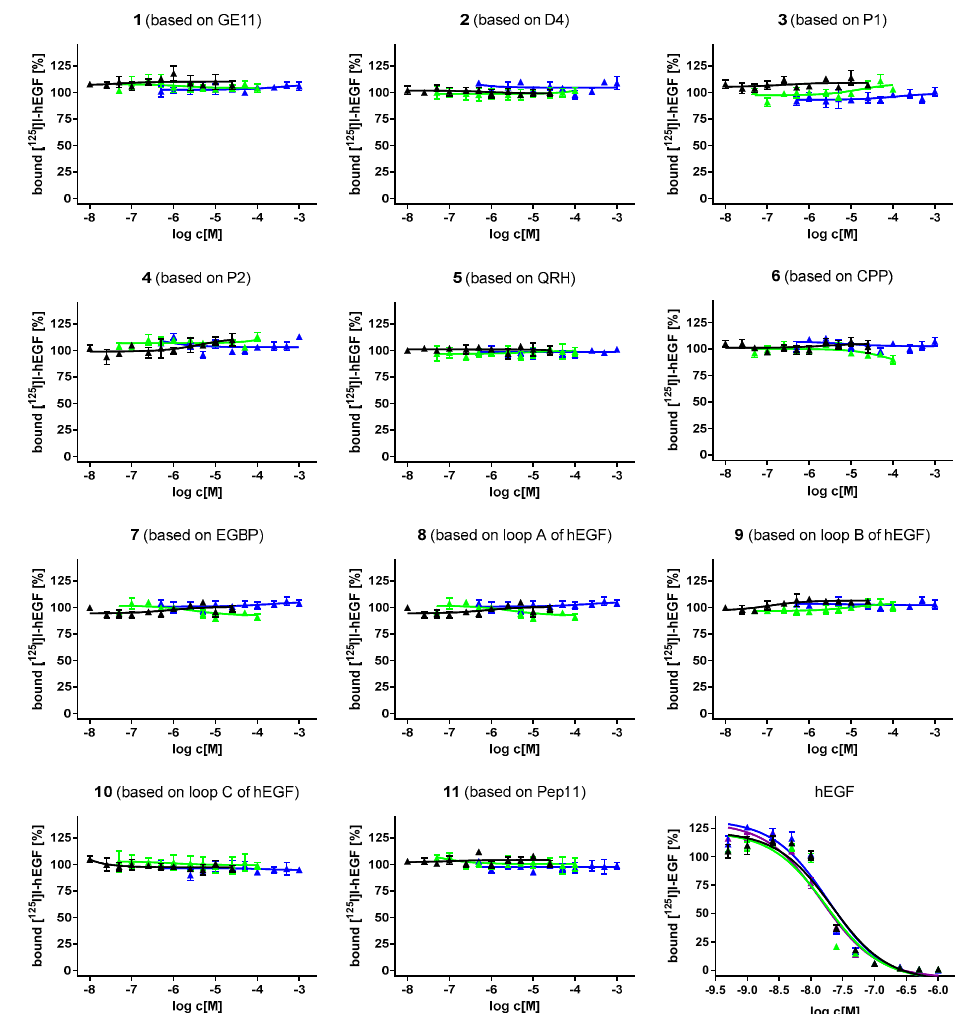
Figure 6. Graphical depiction of the results of the competitive displacements assays of 1 – 11 as well as the positive control hEGF on EGFR-positive A431 cells using [ 125 I]I-hEGF as the competitor. Each experiment was performed at least thrice, each in triplicate, depicted in different colors.